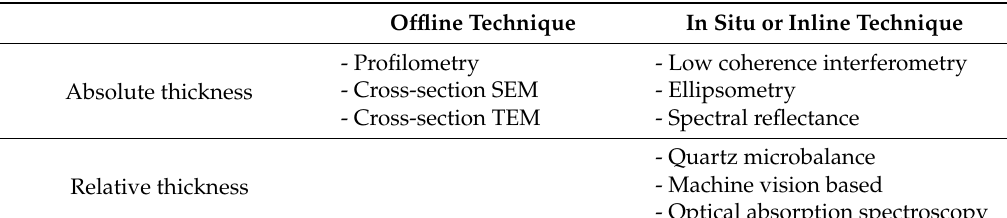
Table 3. Thin film thickness measurement